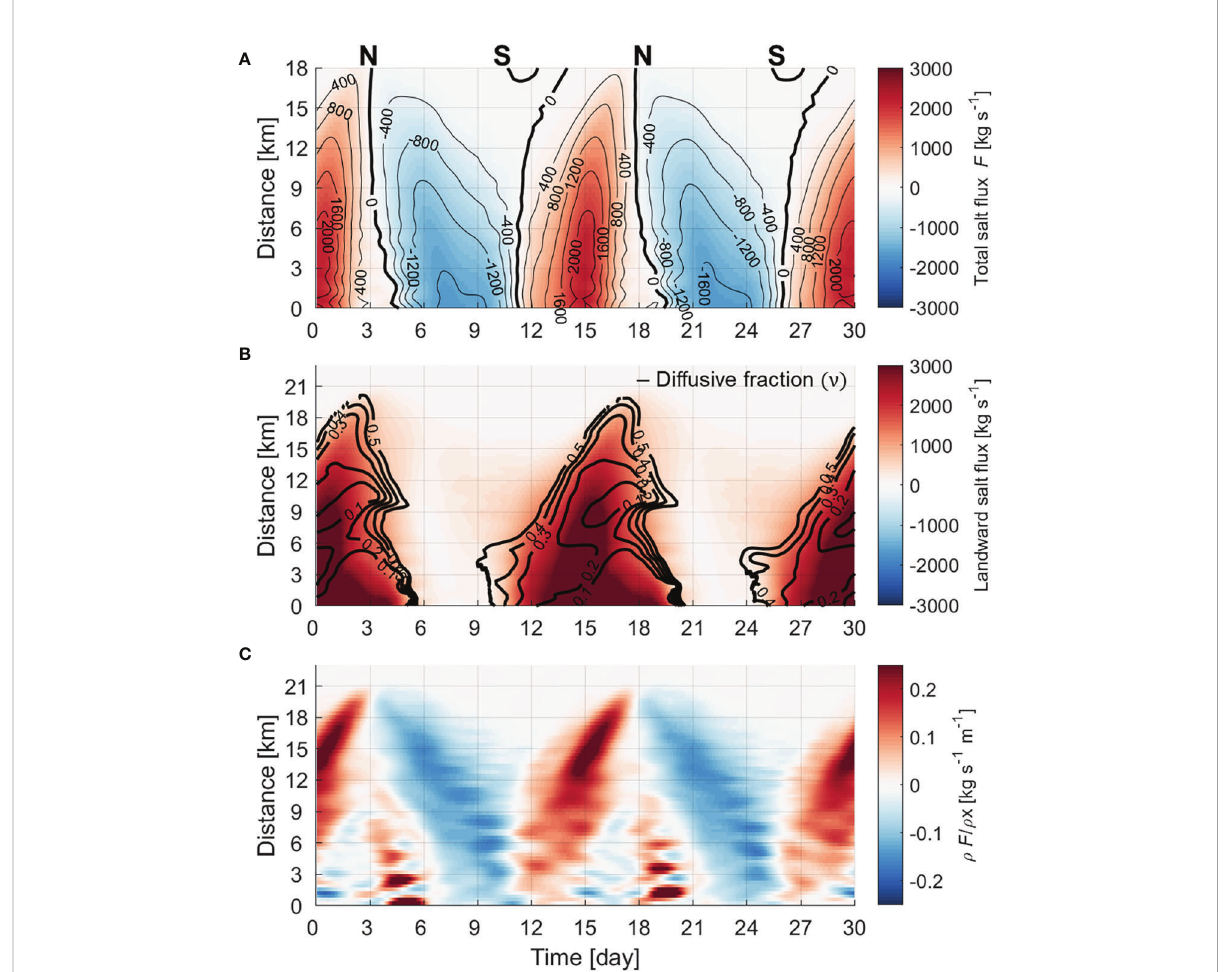
FIGURE 6 Hovmöller diagrams of the (A) total horizontal salt fl ux (F) , (B) landward salt fl ux (color shading: steady shear dispersion salt fl ux [ F E ] + tidal oscillatory salt fl ux [ F T ]; unit: kgs -1 ) and diffusive fraction ( v ; black contour lines), and (C) convergence of total salt fl ux (unit: kgs -1 m -1